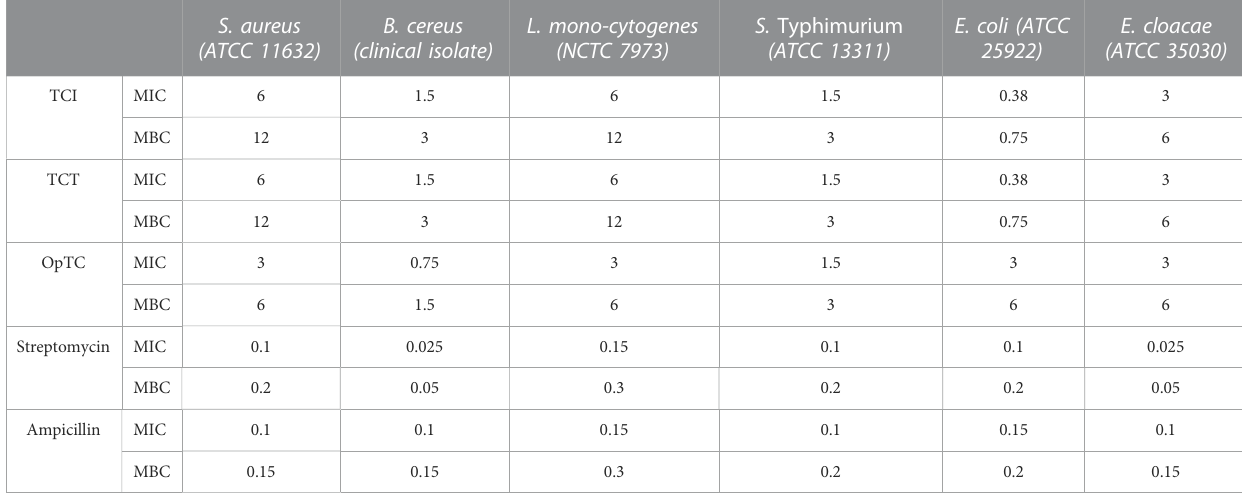
TABLE 4 MIC and MBC values (mg/ml) of the herbal preparations obtained from Thymus comosus after the evaluation of their antibacterial potential.